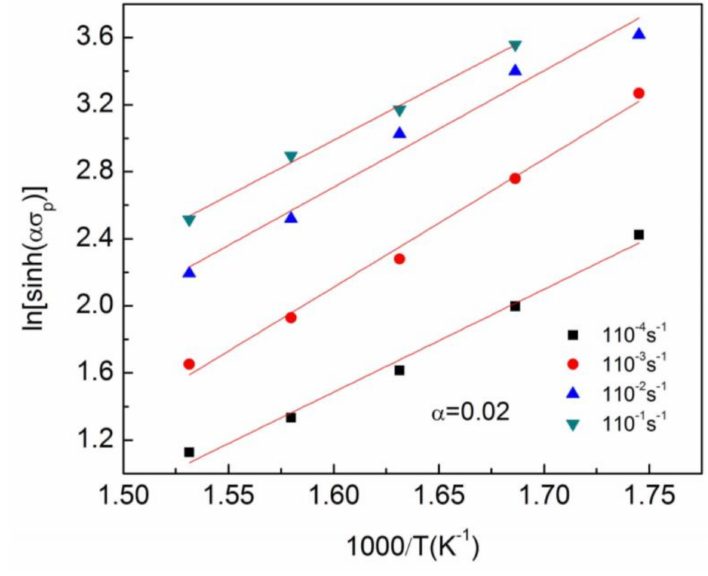
Figure 12. The linear relationship between ln[sinh ( ασ )] and